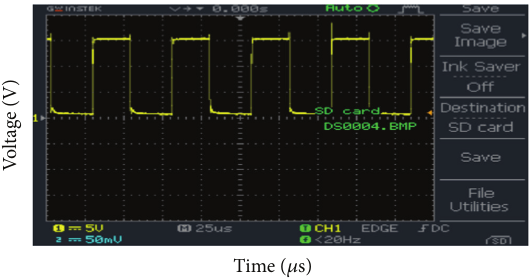
Figure 10: CCP1 pin output of PIC.